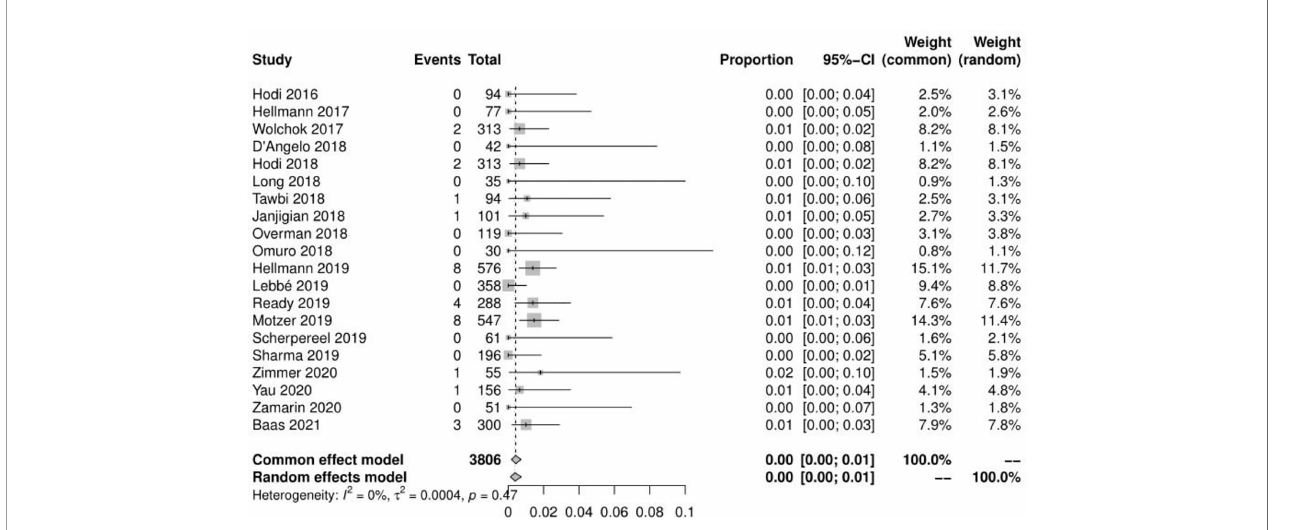
FIGURE 4 | Forest plot of treatment-related deaths.